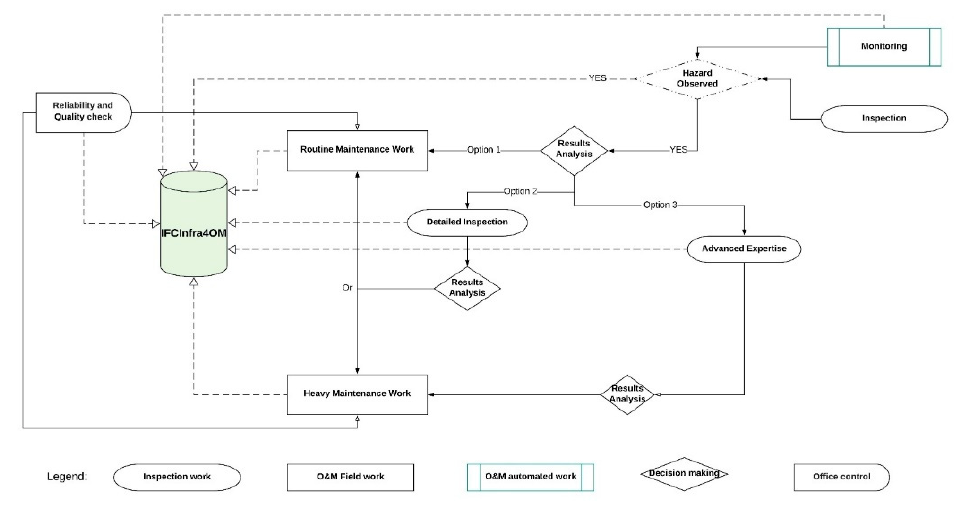
Figure 3. O&M Process for Highway Infrastructure.